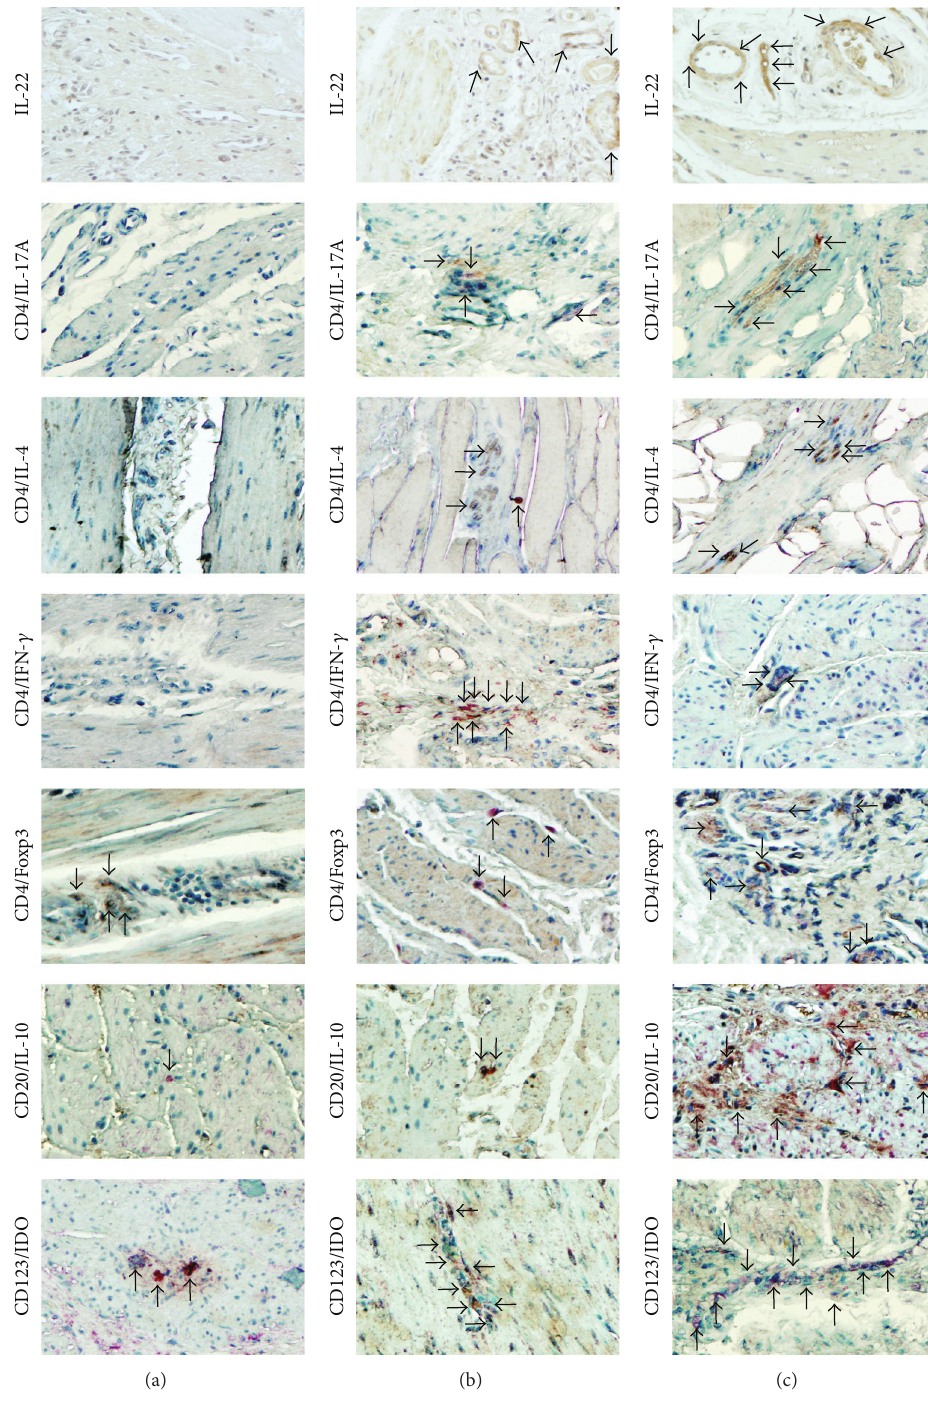
Figure 2: CD4 effector T cells and regulatory cells in lower oesophageal sphincter. Representative photomicrograph from control (healthy donor, (a)), type II achalasia (b), and Barrett’s oesophagus/type II achalasia patient (c). Arrows depict immunoreactive cells. Original magnification was ×